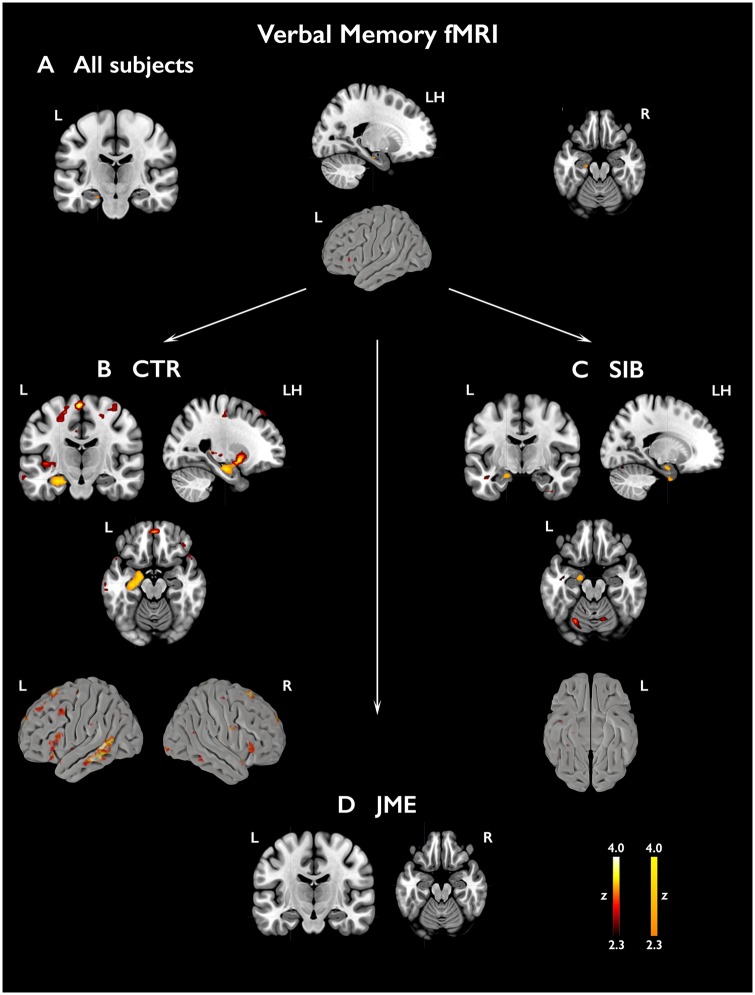

Activations related to subsequent verbal memory. Activations in relation to subsequently remembered verbal items (WR-WF) are shown across all subjects (A) and separately for each group [B, controls; C, siblings (SIB); D, patients with JME]. Statistical maps for mesiotemporal activations (orange-yellow scale) show voxels included in the 12-mm diameter spherical regions of interest used for multiple comparison correction, centred on local maxima, where peak-level significance at P < 0.05-FWE corresponds to z-scores >2.3). Extra-mesiotemporal activations are displayed at an uncorrected threshold (P < 0.01, cluster extent threshold of 10 voxels; ‘hot’ colour scale). ‘LH’ refers to a sagittal section of the left hemisphere. Colour bars reflect z-score scales for mesiotemporal (right) and extra-mesiotemporal activations (left). MNI coordinates and parameter estimates are provided in Supplementary Table 2.